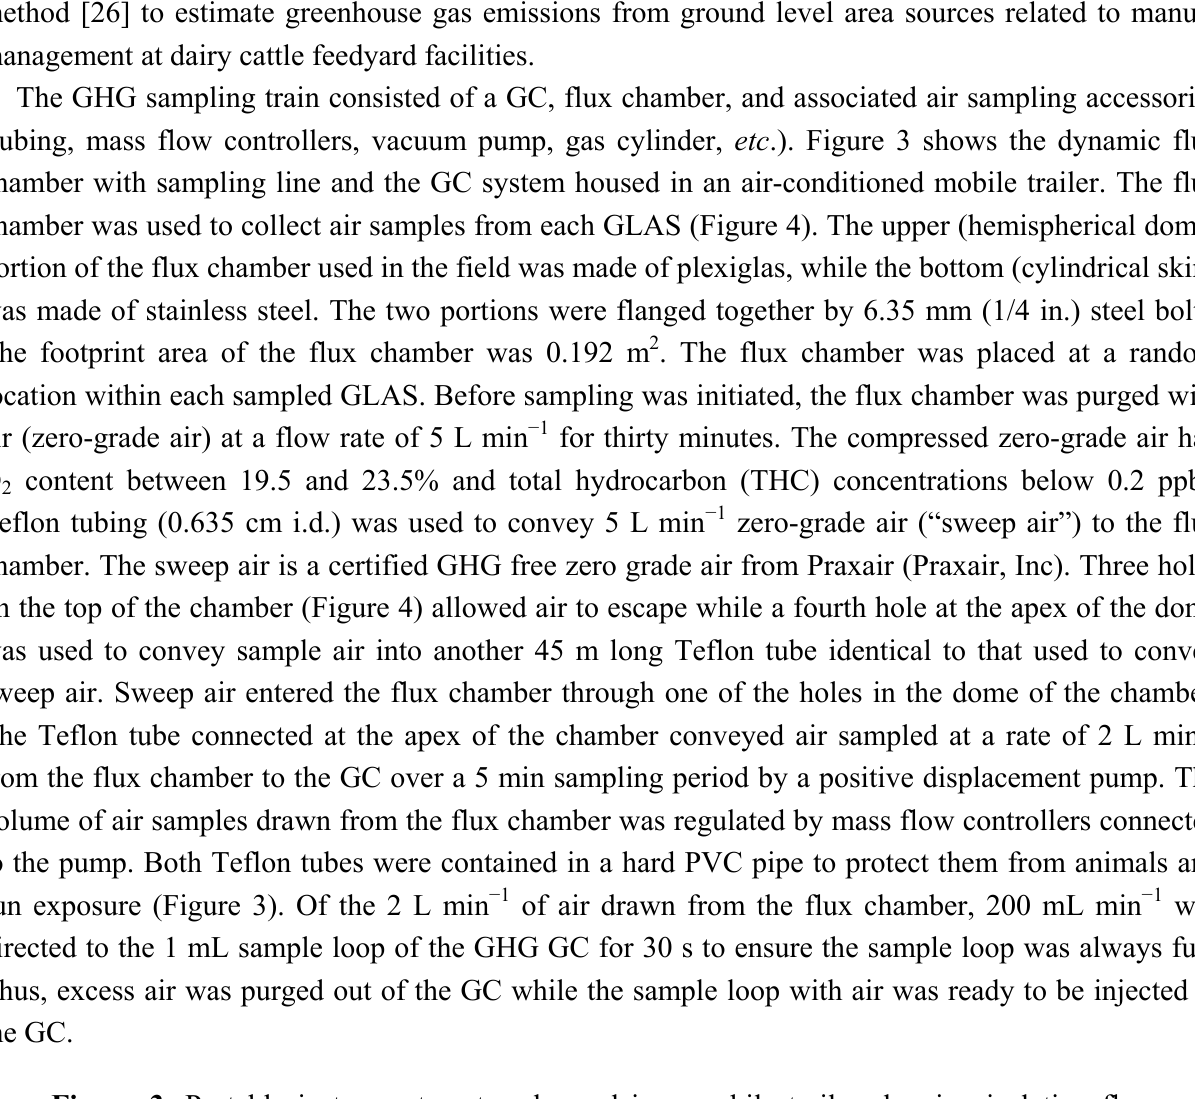
Figure 3. Portable instrument system housed in a mobile trailer showing isolation flux chamber and sampling